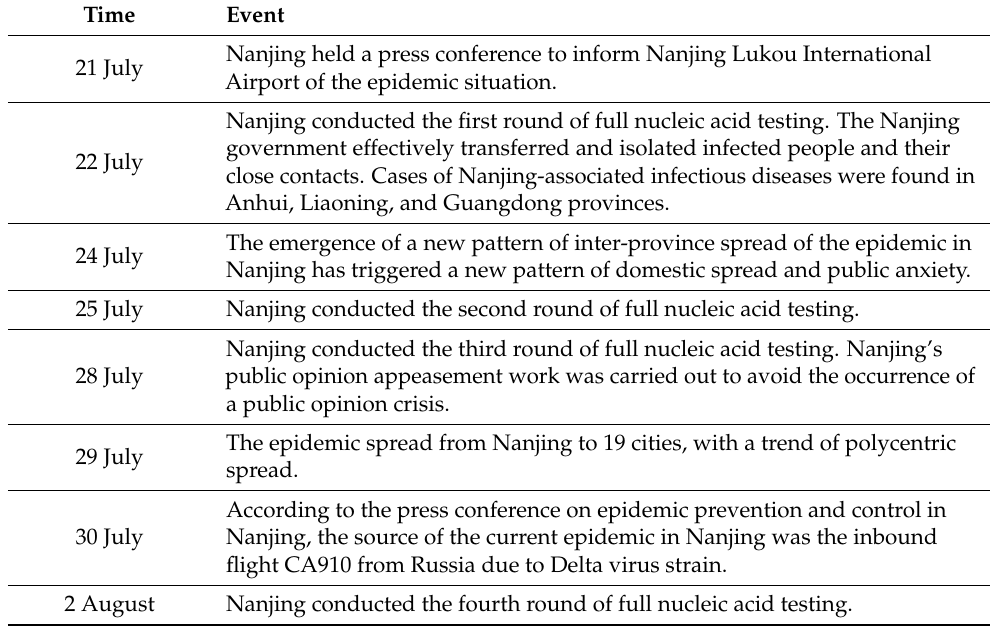
Table 14. The process events timeline for the Nanjing COVID-19 epidemic.